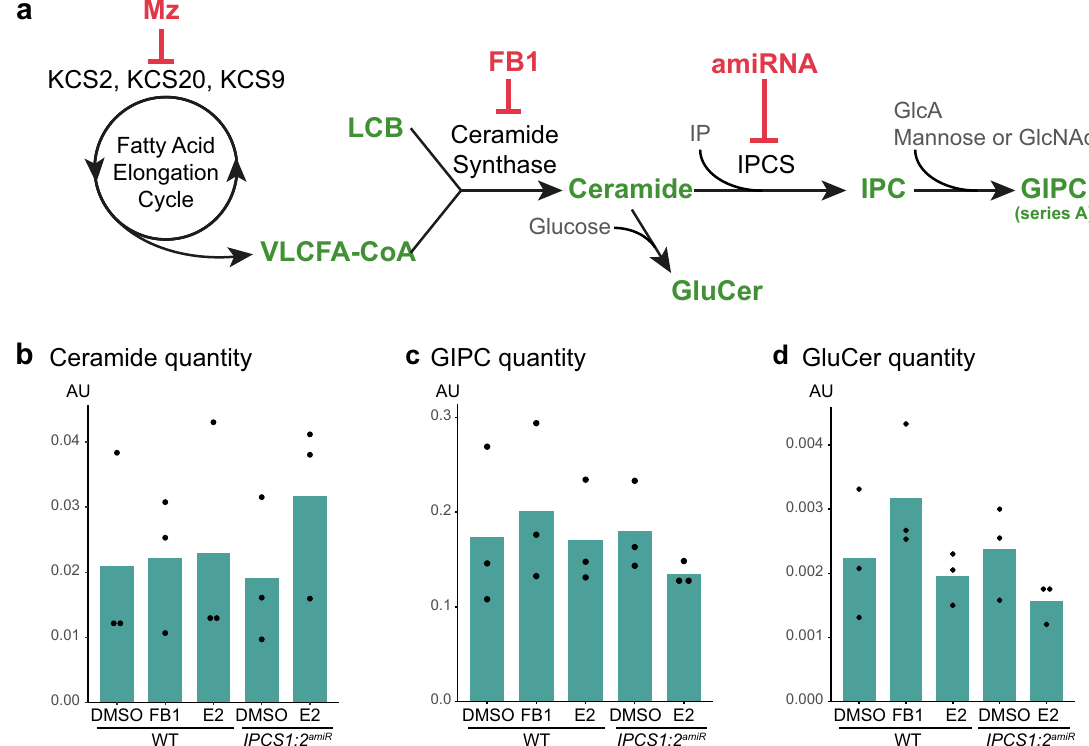
Fig. 6 Sphingolipidomics of IPCS1;2amiRNA line and FB1-treated Arabidopsis roots. a Simpli fi ed outline of sphingolipid biosynthesis pathway in plants. KCSs enzymes are part of the elongase complex that elongates fatty acids of 2 carbons per cycle to produce VLCFAs-CoA. Metazachlor inhibits KCS2, 20 and 9. VLCFAs-CoA is condensed with a long chain base (LCB) by the ceramide synthases LOH1 and LOH3 to produce VLCFAs-ceramide. FB1 inhibits LOH1 and LOH3. Ceramide is the substrate of the glucosylceramide synthase1 (GCS1) enzyme that grafts a glucose on ceramide to produce glucosylceramide (GluCer). Alternatively, ceramide is the substrate of the inositolphosphorylceramide (IPC) synthases (IPCSs) enzymes that graft a inositolphosphate (IP) group on ceramide to produce IPC. IPC is further glycosylated by addition of a glucuronic acid (GlcA) and mannose or to a minor extend N-acetylglucosamine (GlcNAc) residues to produce glycosylinositolphosphorylceramides (GIPCs) of series A, the most abundant form of sphingolipids in Arabidopsis . b – d Sphingolipidomics of Arabidopsis roots, these analyses are displayed in details in supplementary Fig. 5 ( n = 3 biological replicates, the dots show the dispersion of data, AU: Arbitrary Unit (area of peak compound/area of internal standard per mg fresh weight)). b The total quantity of ceramides increases in the IPCS1;2 amiRNA line induced by β -estradiol (E2) while it is not altered upon FB1 treatment. c , d The total quantity of GIPC ( c ) or GluCer ( d ) decreases in the IPCS1;2 amiRNA line induced by β -estradiol (E2) while it increases upon FB1